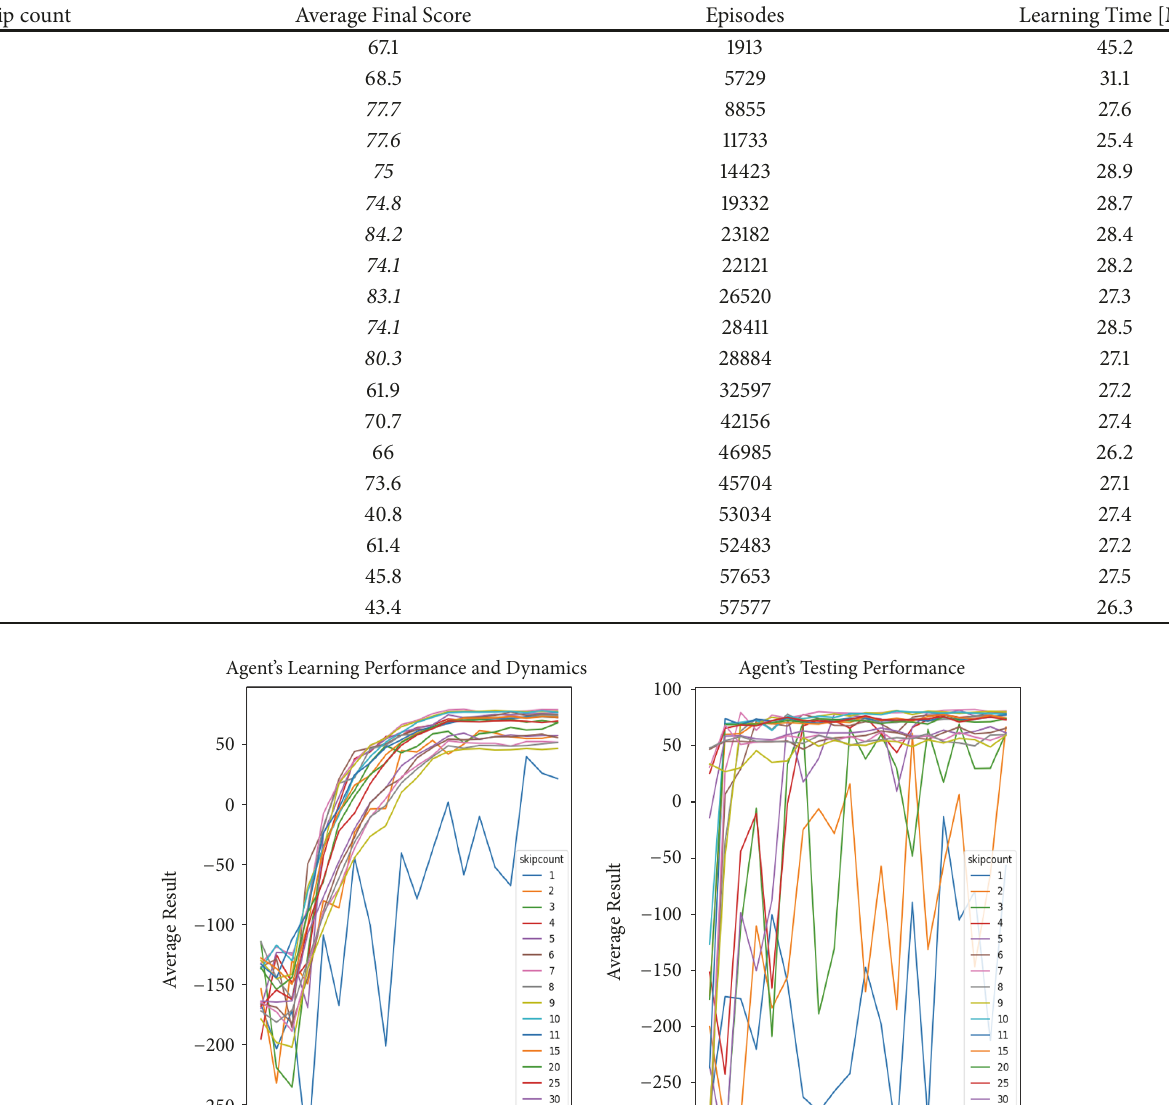
Table 1: Agent final performance for each skip count that affects the learning performance.